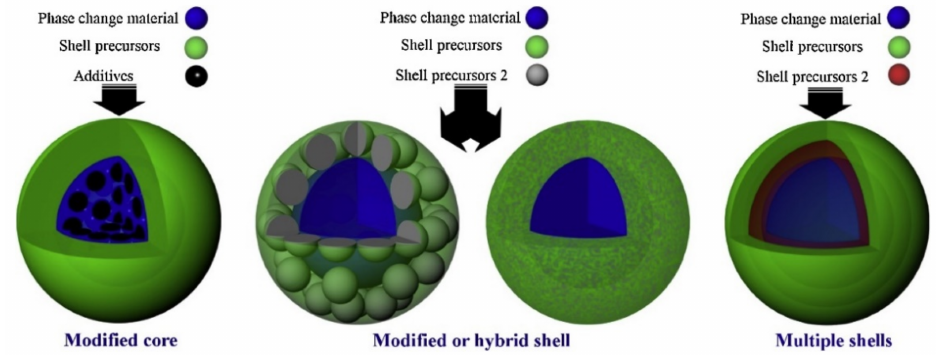
Figure 14. Different shape of multifunctional mPCMs